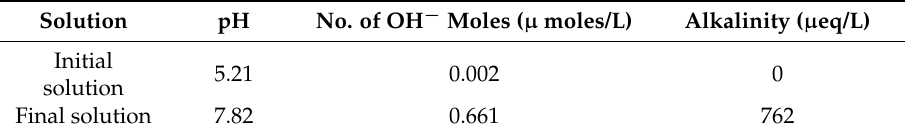
Table 6. Solution pH, number of OH − moles, and